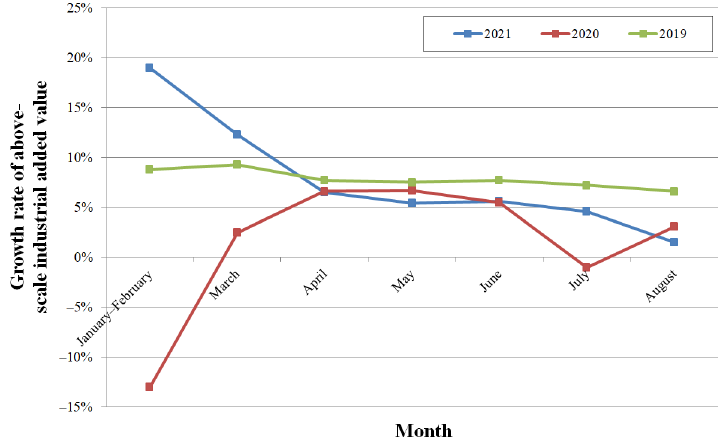
Figure 8. The YoY growth rate of provincial above-scale industrial added value.